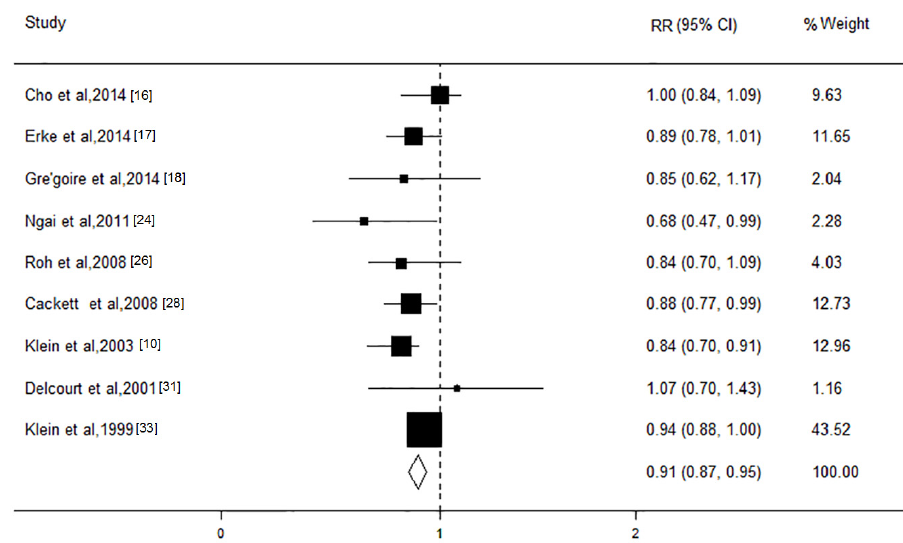
Figure 5. Forest plot on the associations between the triglycerides level and age ‐ related macular degeneration. The boxes and lines indicate the relative risks (RRs) and their 95% confidence intervals (CIs) on a log scale for each study. The pooled relative risk is represented by a diamond. The size of the black squares indicates the relative weight of each estimate.